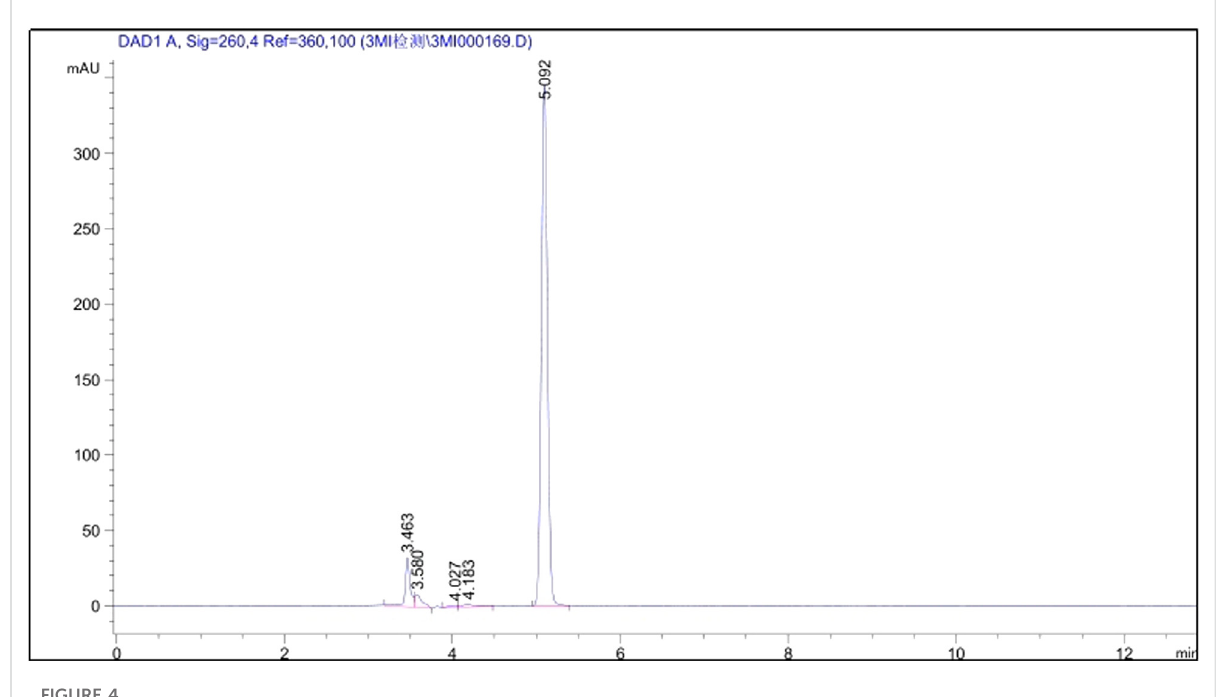
FIGURE 4 Standard curve of 3MI detected by liquid chromatography.